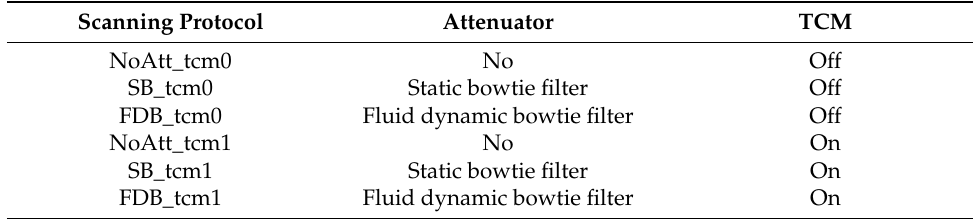
Table 3. Scanning protocols are simulated in this